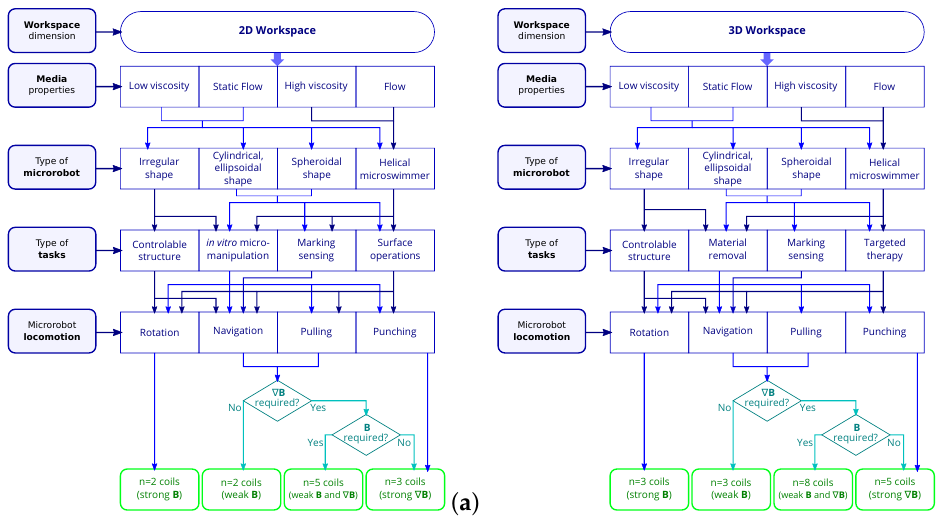
Figure 3. The diagram of the specifications of EMA system design for ( a ) 2D and ( b ) 3D